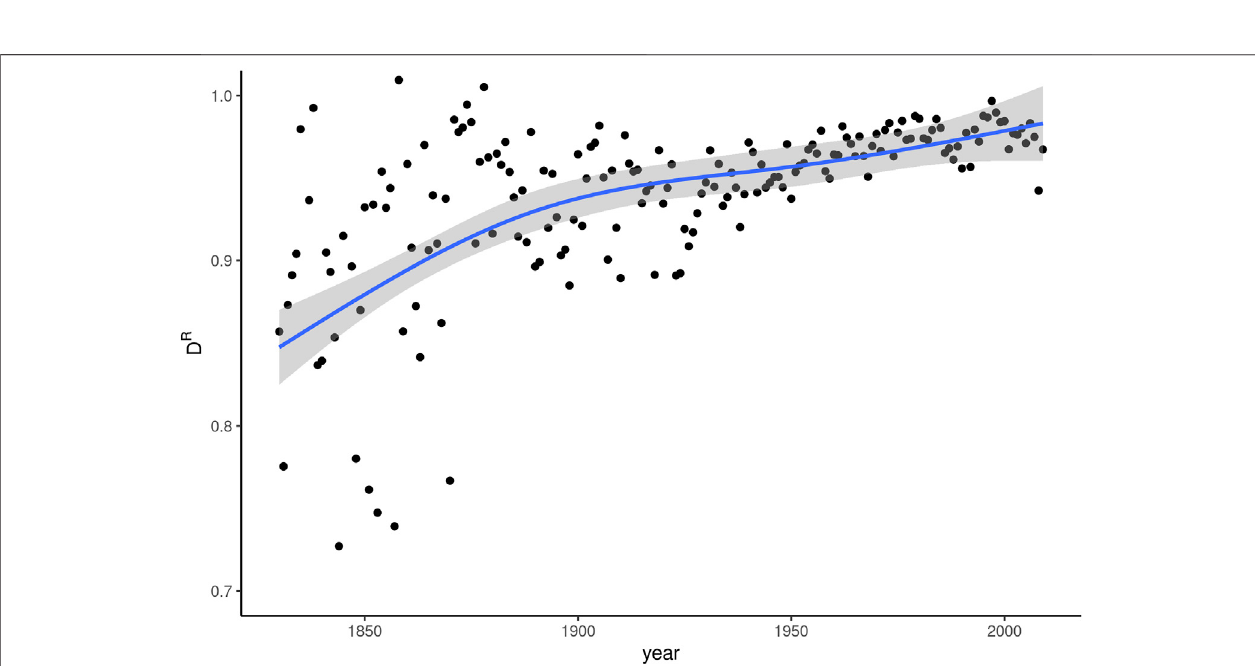
FIGURE 4 | Register dissemination (D R ) of whom over 180 years of written American